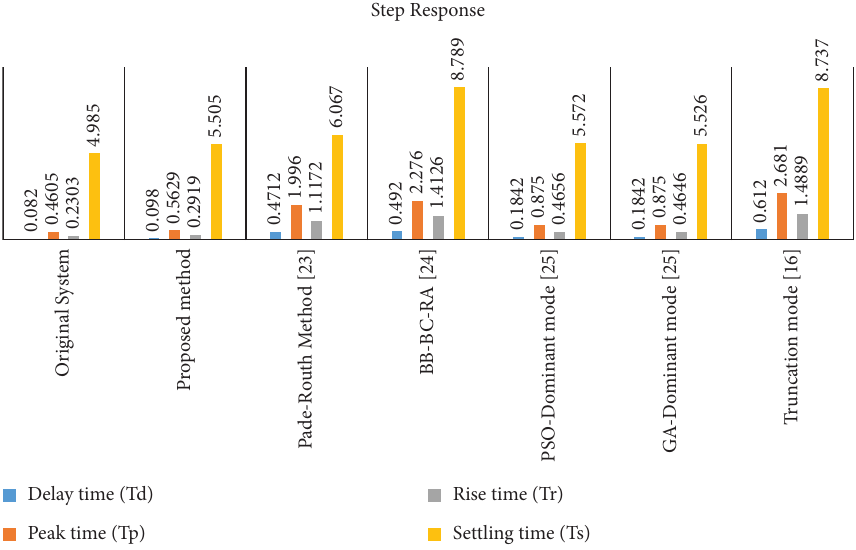
Figure 6: Step responses of the original system are compared to reduced models obtained using other